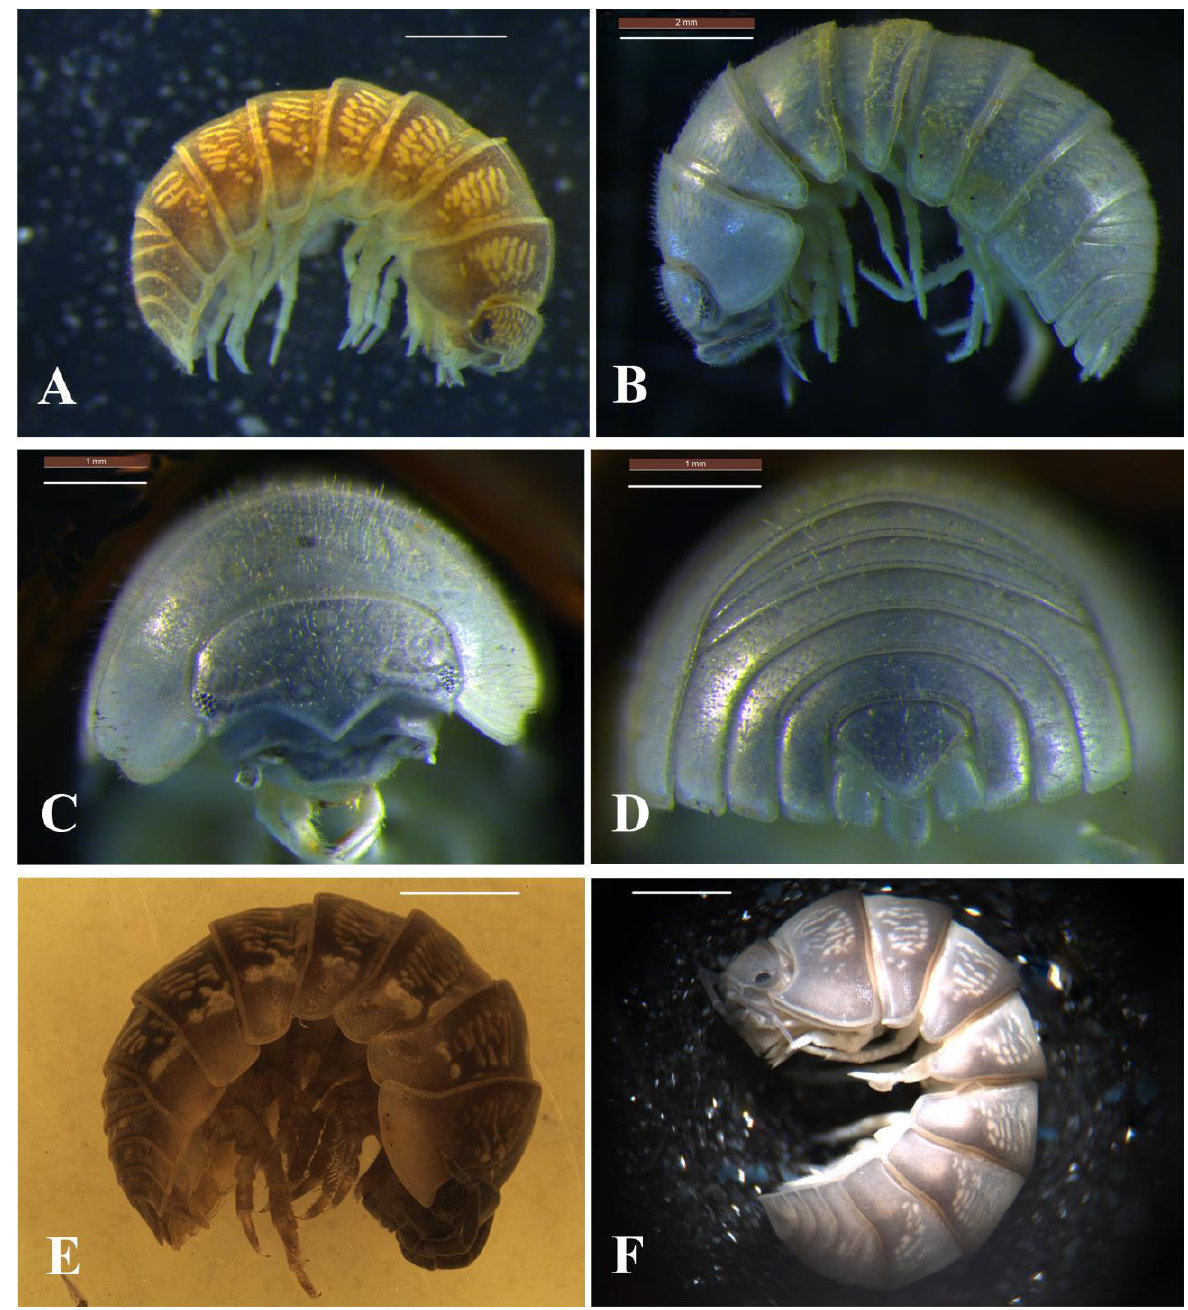
F IGURE 2. A-D, Schizidium golovatchi ; E, Armadillidium azerbaidzhanum ; F, Armadillo officinalis . A, B, habitus, lateral view; C, head, dorsal view; D, pleon, dorsal view; E, habitus, lateral view; F, habitus, dorsal view. Scale = A-B, E-F, 2 mm; C-D, 1